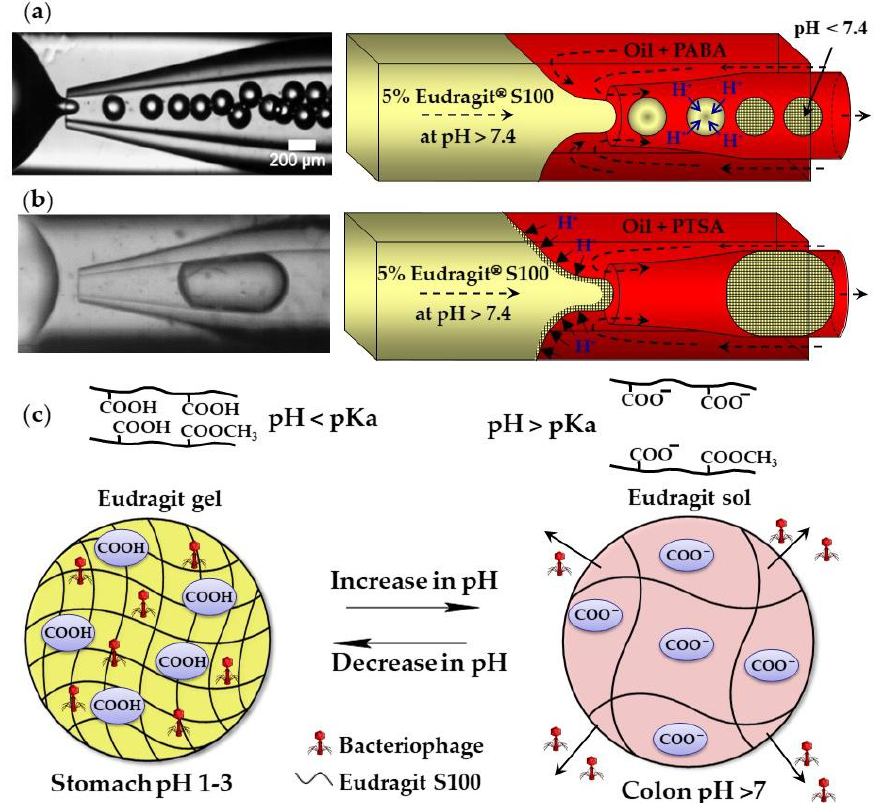
Figure 5. Formation of Eudragit S100 beads by external gelation of aqueous Eudragit droplets in acidified oil. ( a ) Sol–gel transition within droplets triggered by 1 wt% p-aminobenzoic acid (PABA) dissolved in mineral oil. ( b ) Premature sol–gel transition triggered by 1 wt% p-toluenesulfonic acid (PTSA) dissolved in mineral oil. ( c ) Site-specific release of bacteriophage from gel beads. The disentanglement of polymer chains occurs as a result of the electrostatic repulsion between negatively charged carboxyl groups of methacrylic acid monomer units at a pH value above the polymer pKa